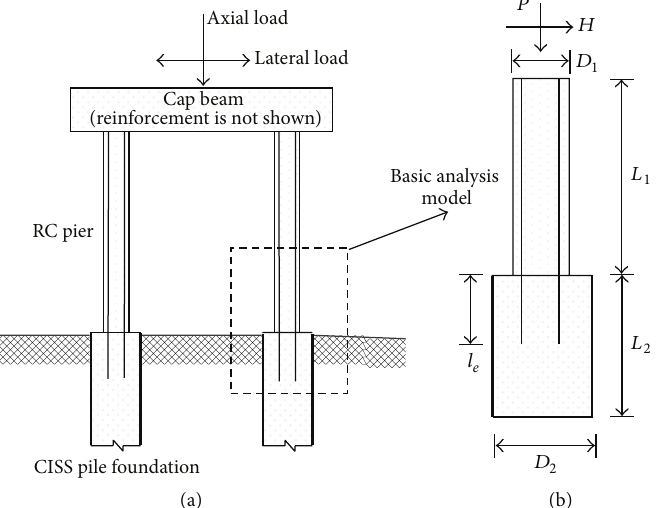
Figure 2: Geometry of (a) CISS pile-to-reinforced concrete pier connection and (b) basic analytical model. Note: all shear reinforcement is not shown.